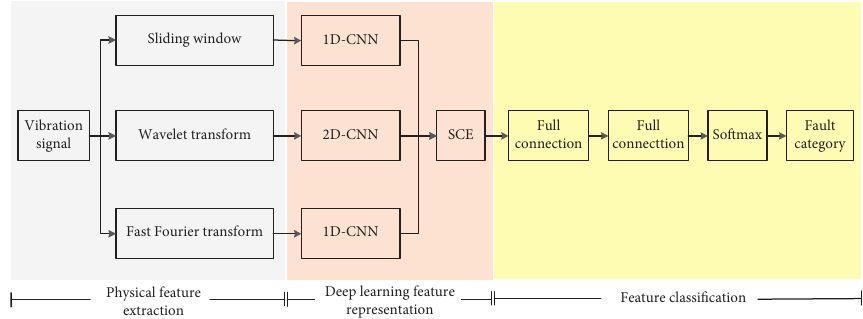
Figure 1: Block diagram of multidomain feature fusion